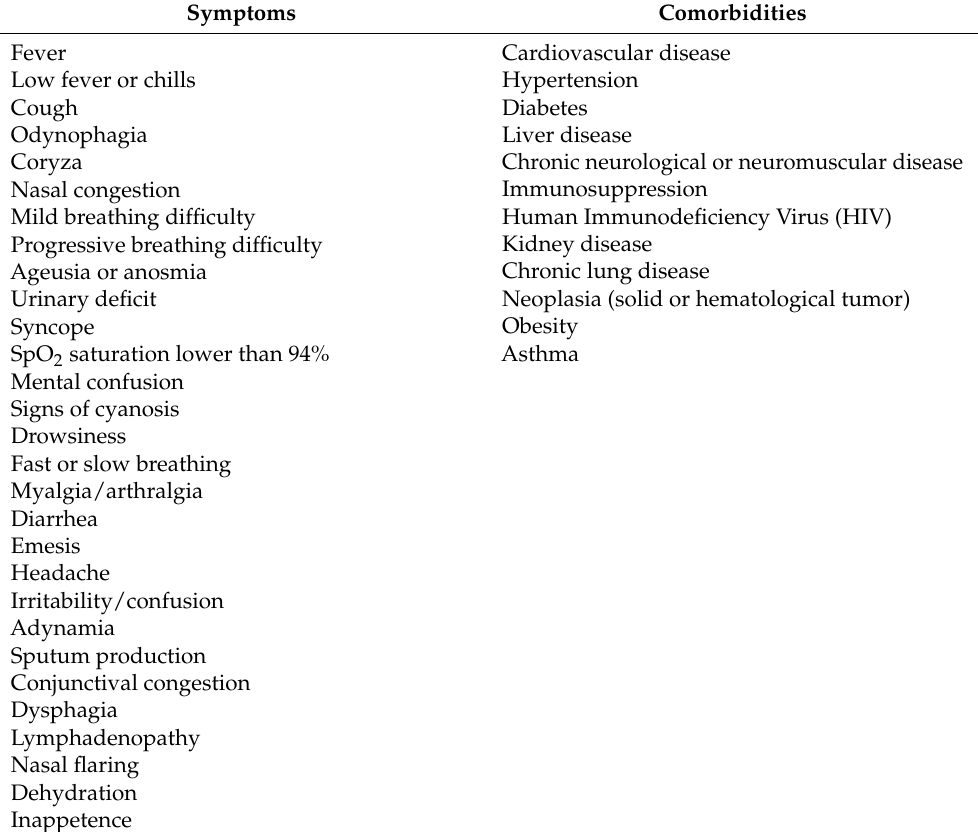
Table 1. Symptoms and comorbidities of COVID-19 patients in Vit ó ria da Conquista, BA, Brazil. Symptoms Comorbidities Fever Cardiovascular